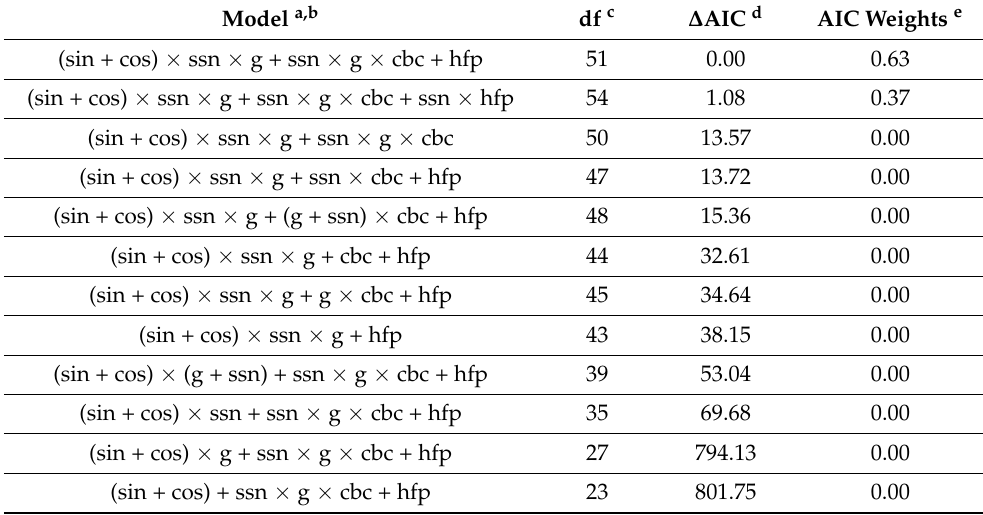
Table 1. Generalized linear mixed models of average hourly movement distances of American White